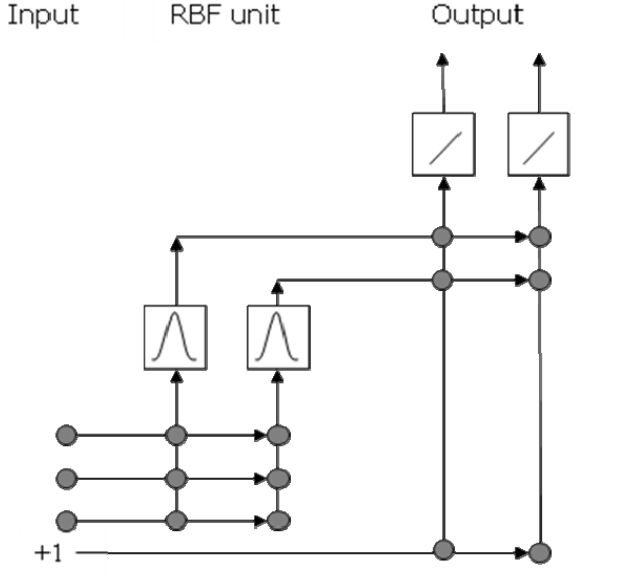
Figure 1. Network architecture of a RBFN. This network has three input neurons, two hidden neurons, and two output